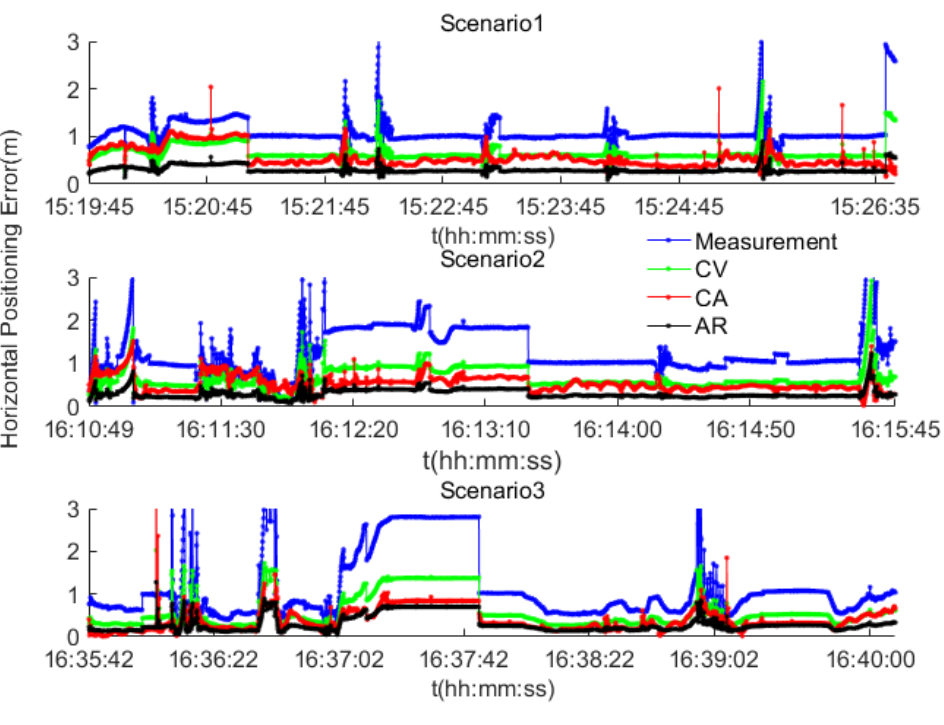
Figure 12. The positioning results for the real tests.